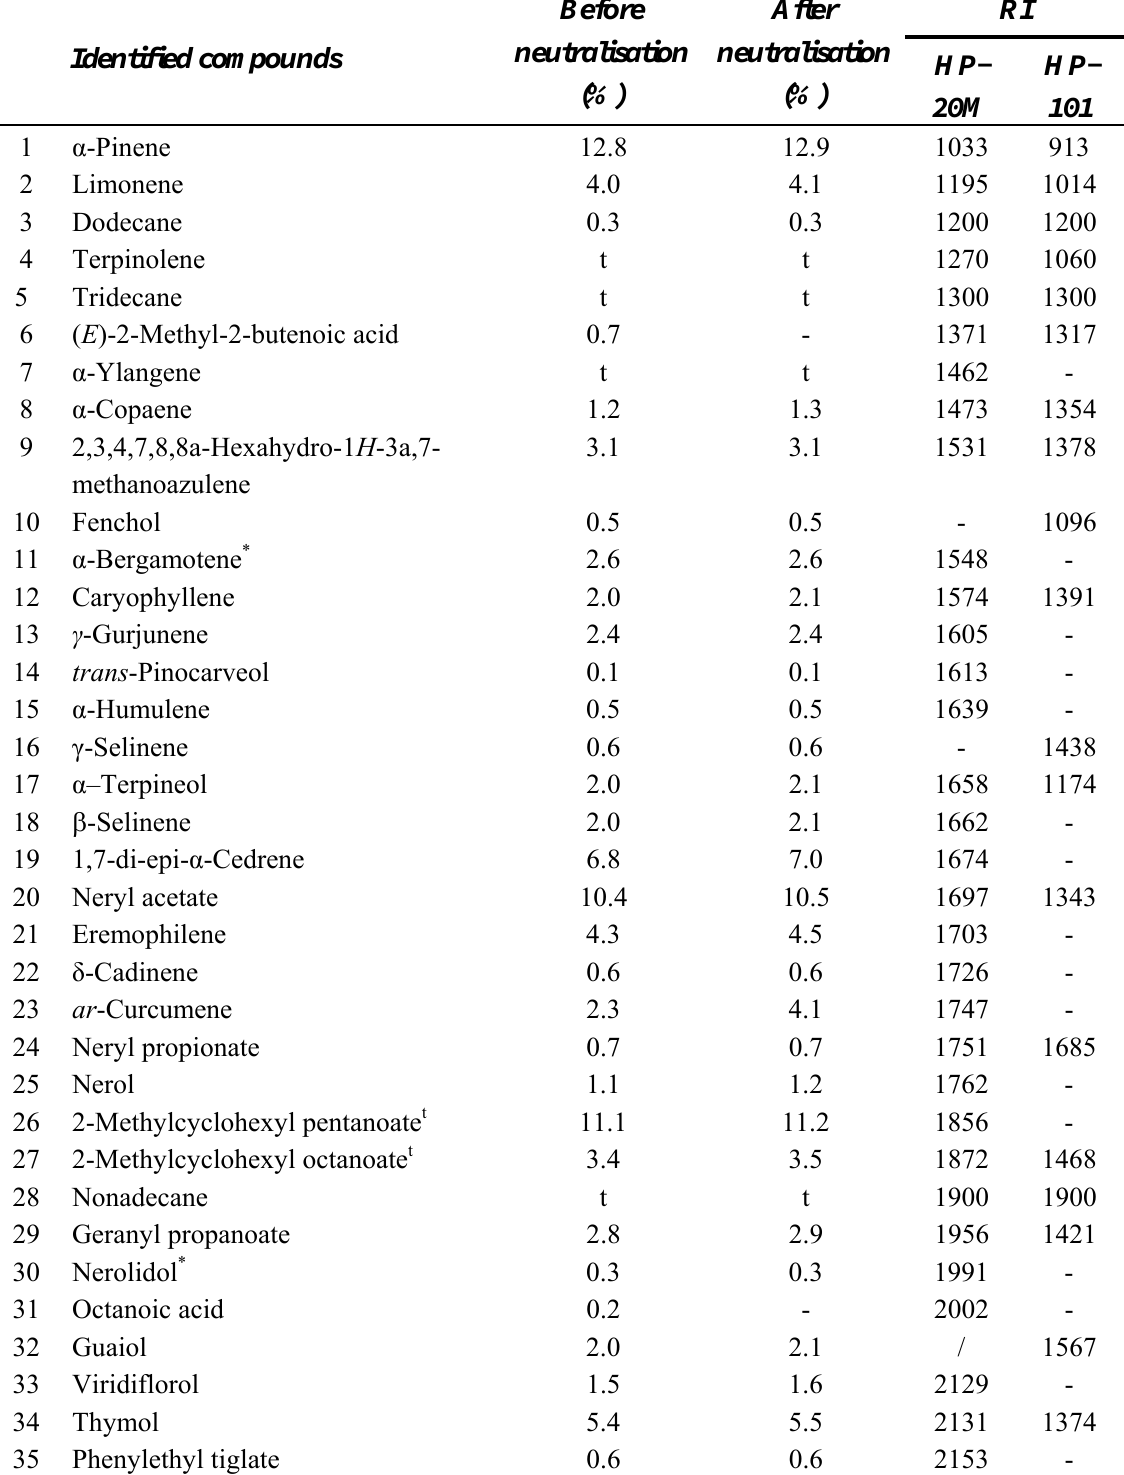
Table 1: Chemical composition of everlasting essential oil before and after